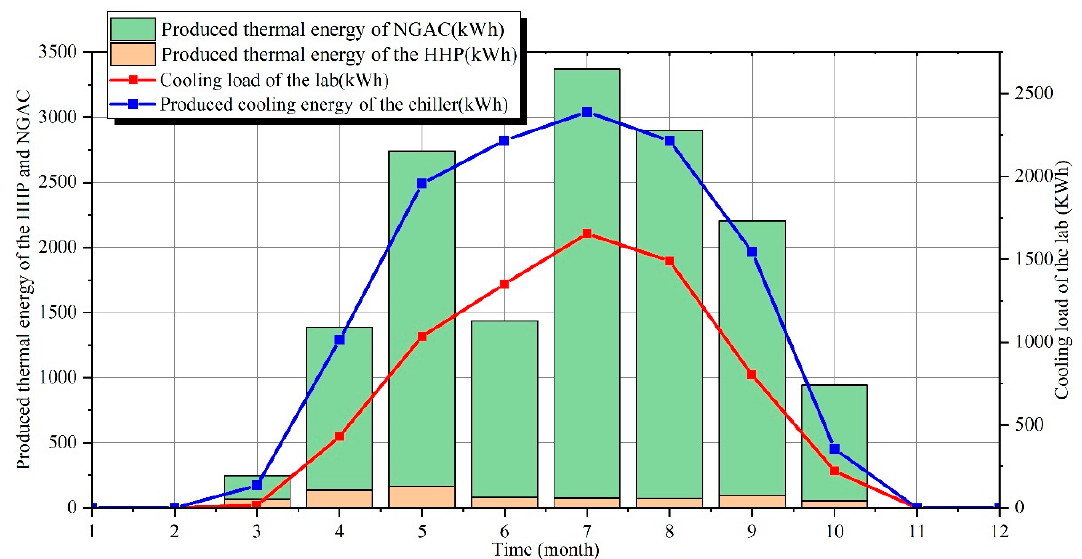
Figure 18. Produced thermal energy of NGAC and HHP during cooling mode.